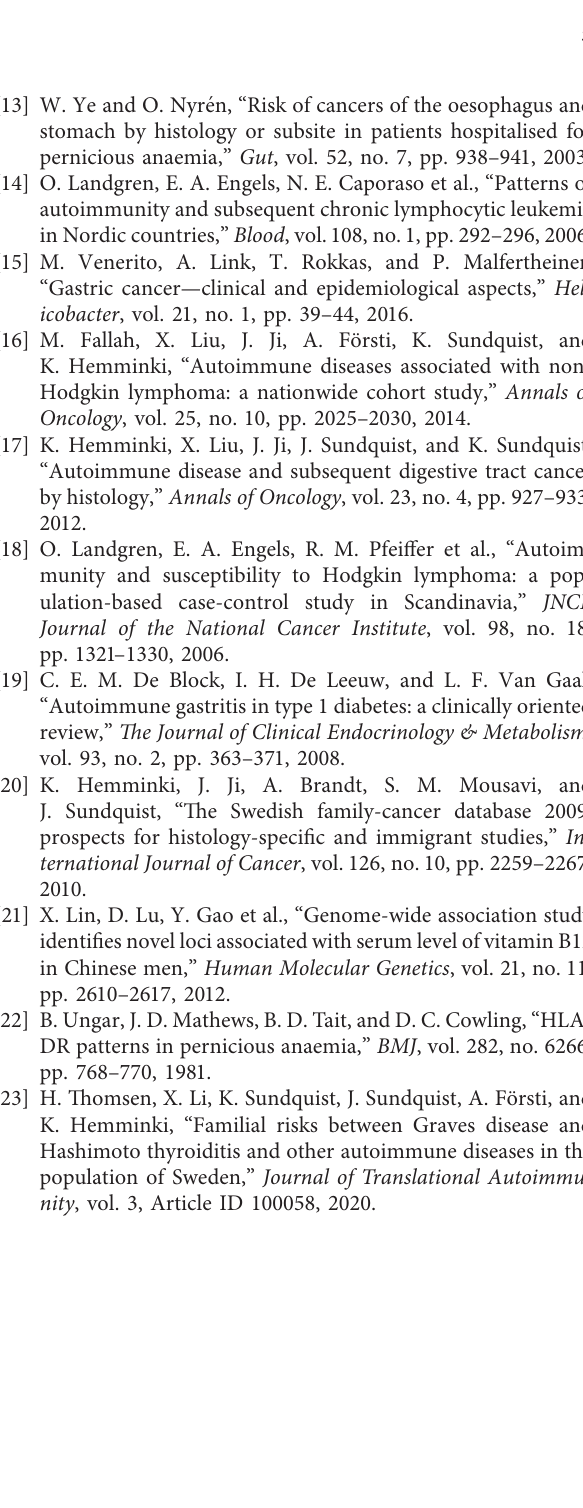
Supplementary Figure 1: age-specific incidence rate (per